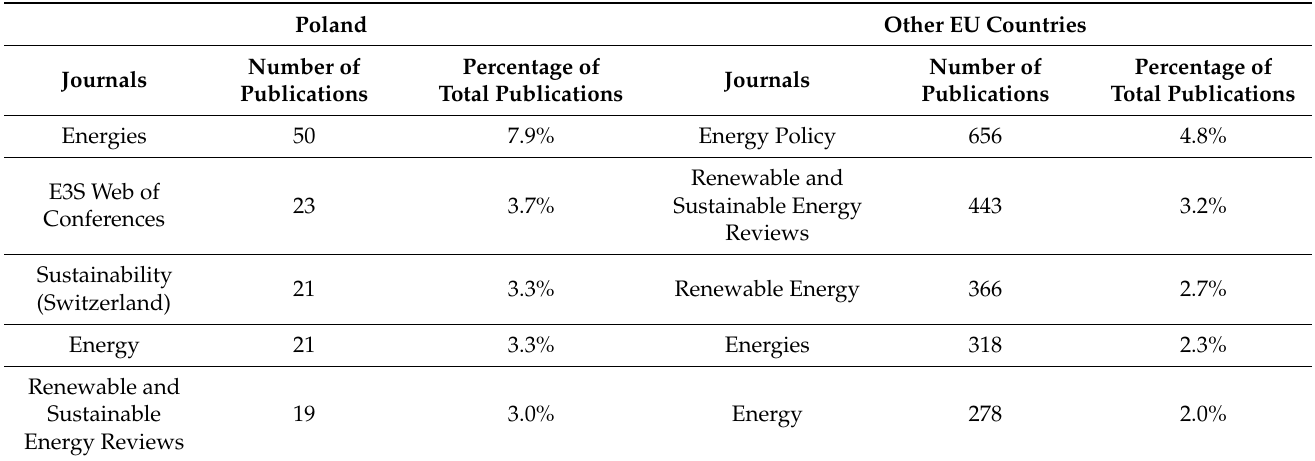
Table 6. Statistics of publications in the top five journals in 2005–2021 (Scopus,